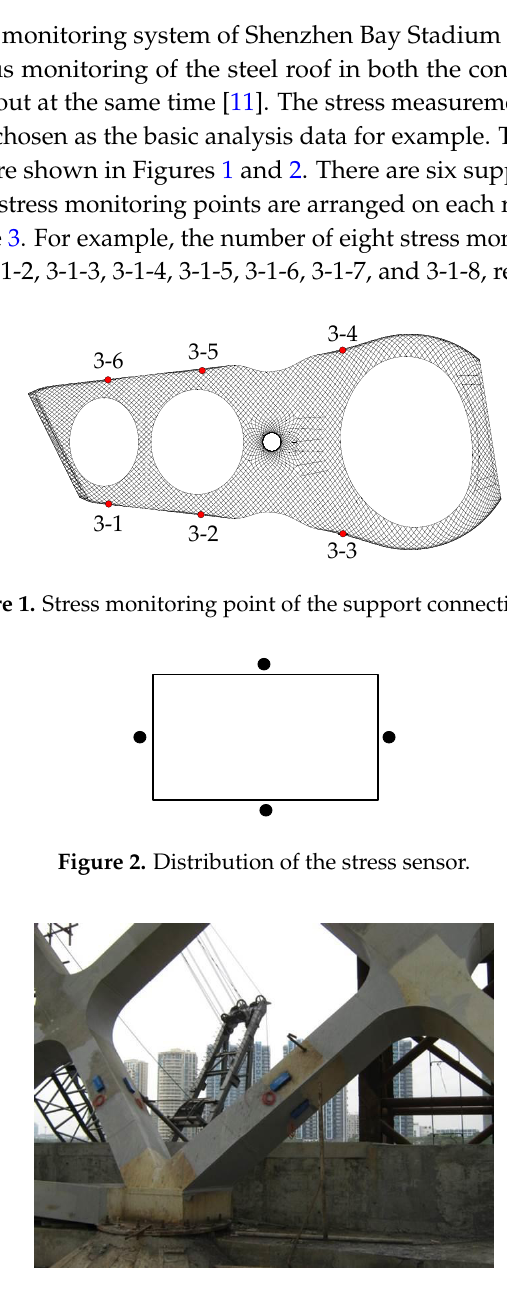
Figure 3. The sensor installation of two support connecting rods.